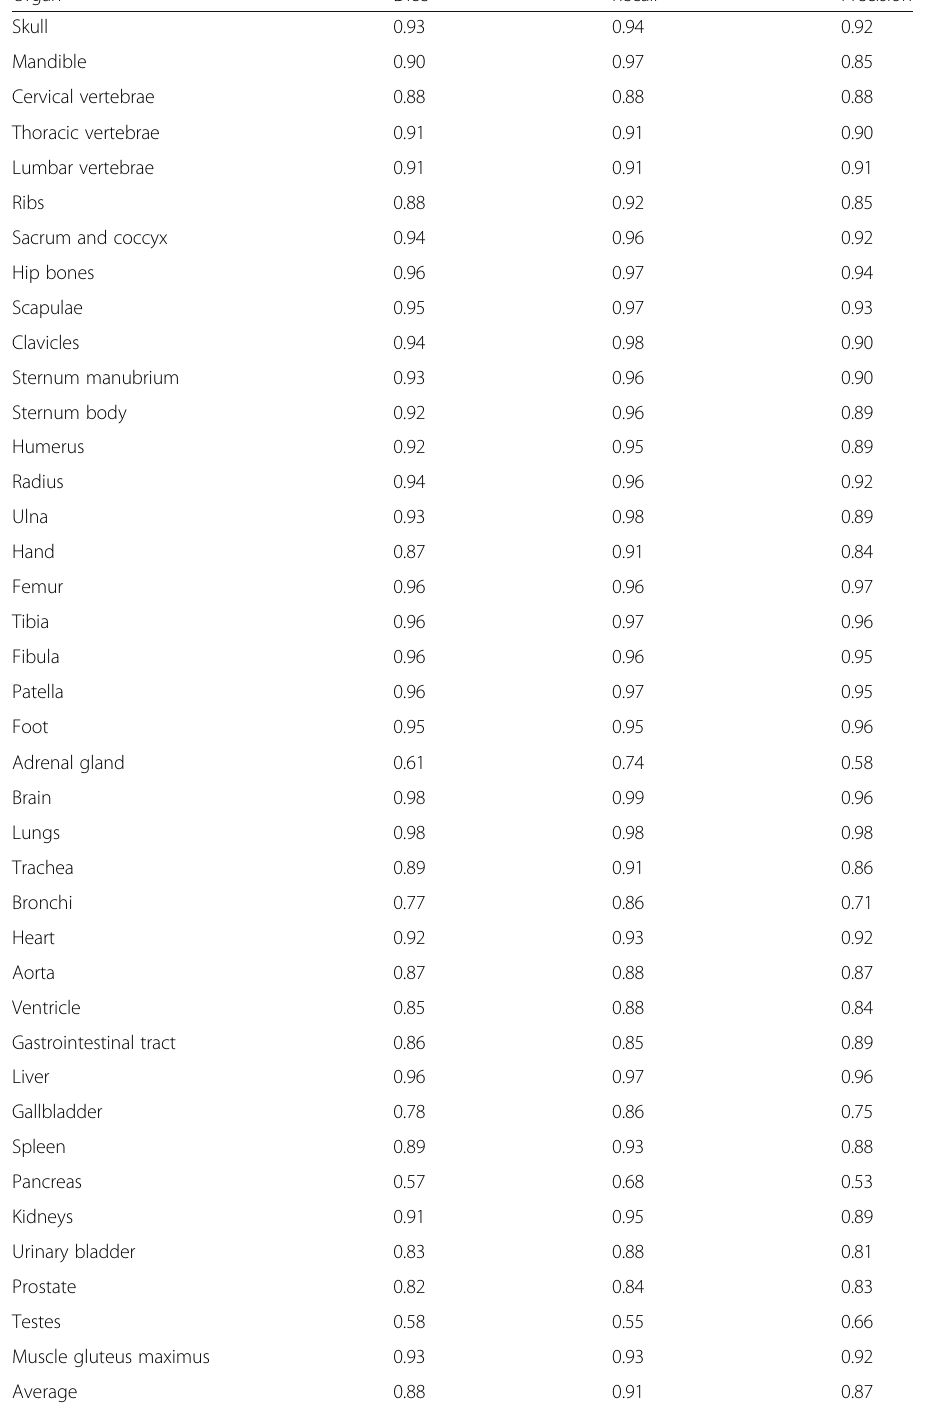
Table 2 Dice index, recall, and precision per organ. Each organ is individually segmented (i.e. the model segmented 24 individual ribs). The metric is presented as the mean over all organs in the same group. The metric for each organ in each group is very similar Organ Dice